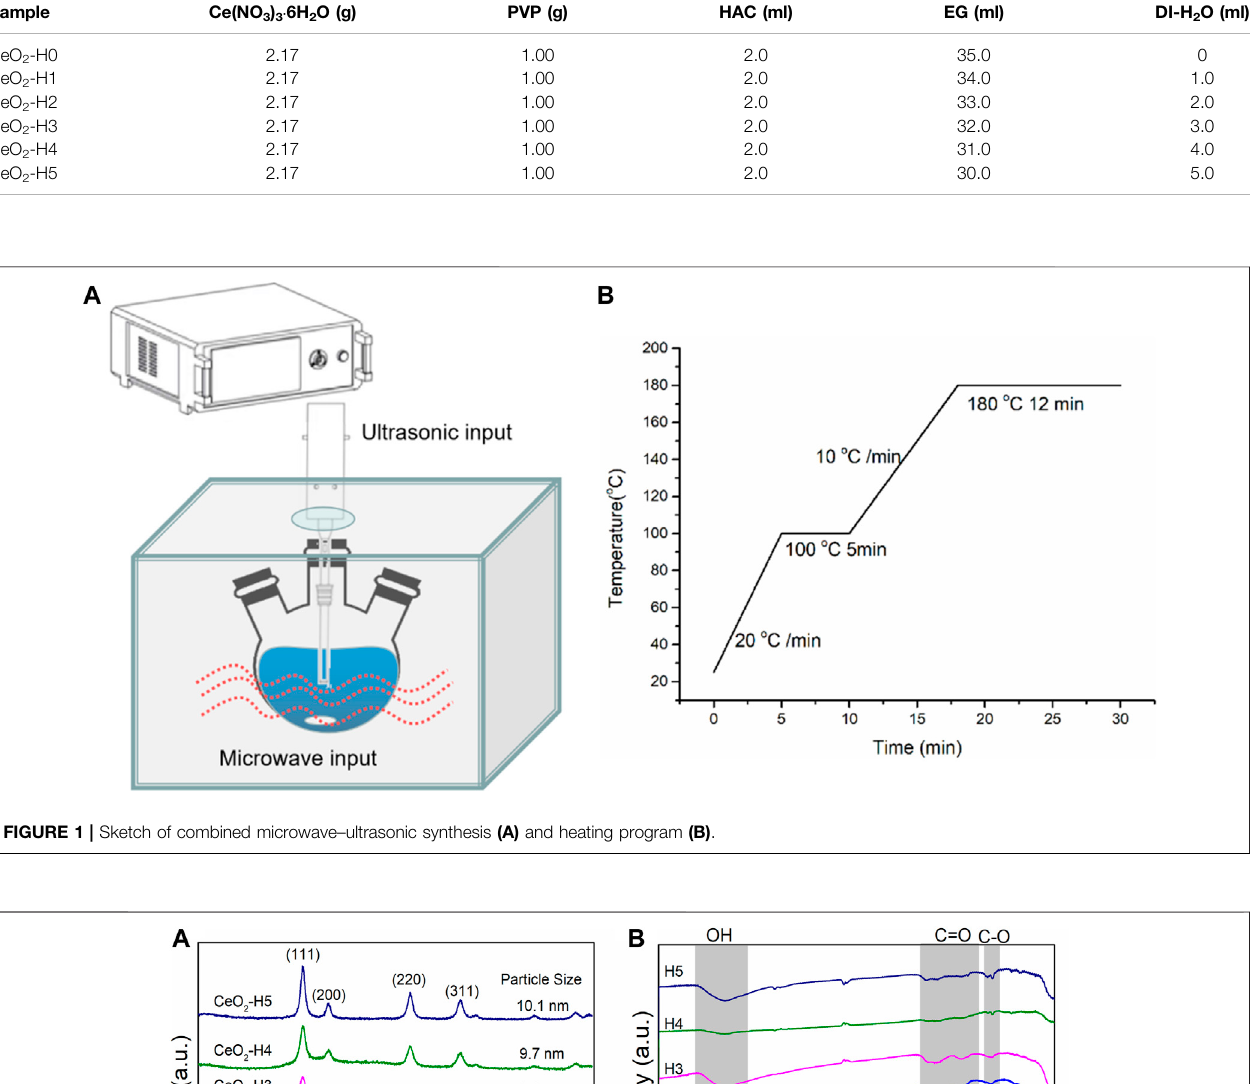
TABLE 1 | Reagents used for different sample syntheses. Sample